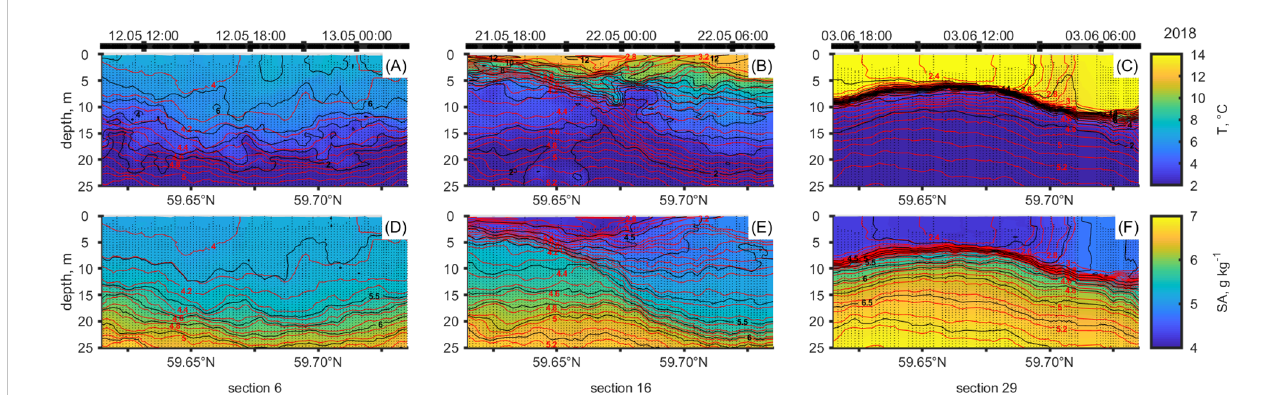
FIGURE 3 Temporal changes in temperature ( A – C , black contours with a step of 1°C) and salinity ( D – F , black contours with a step of 0.5 g kg -1 ) distribution as a function of depth (0 – 25 m) along three glider sections in May – June 2018 (~10 days apart). The distributions are overlaid with red contours marking potential density anomaly with a step of 0.1 kg m -3 . The sampling timeline is at the top of the columns. The left side of a subplot is located closer to the coast and presents the southern part of the section. The area between ticks presenting latitude is about 2.7